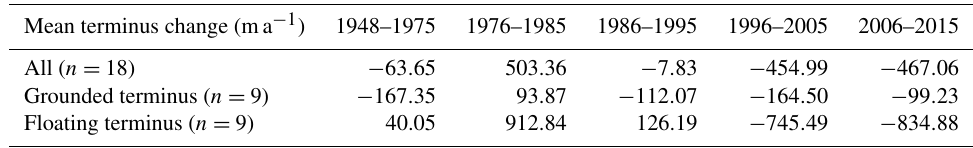
Figure 4. Mean decadal rates of terminus change across northern Greenland. These are shown for five epochs between 1948 and 2015. Increasing red circles represent glacier retreat rates between 0 and exceeding − 1000ma − 1 . Increasing blue circles represent advance rates between 0 and exceeding 1000ma − 1 . Table 2. Mean decadal frontal position change for all study outlet glaciers in northern Greenland, and split based on our two glacier categories of terminus type: grounded terminus or terminating in a floating ice